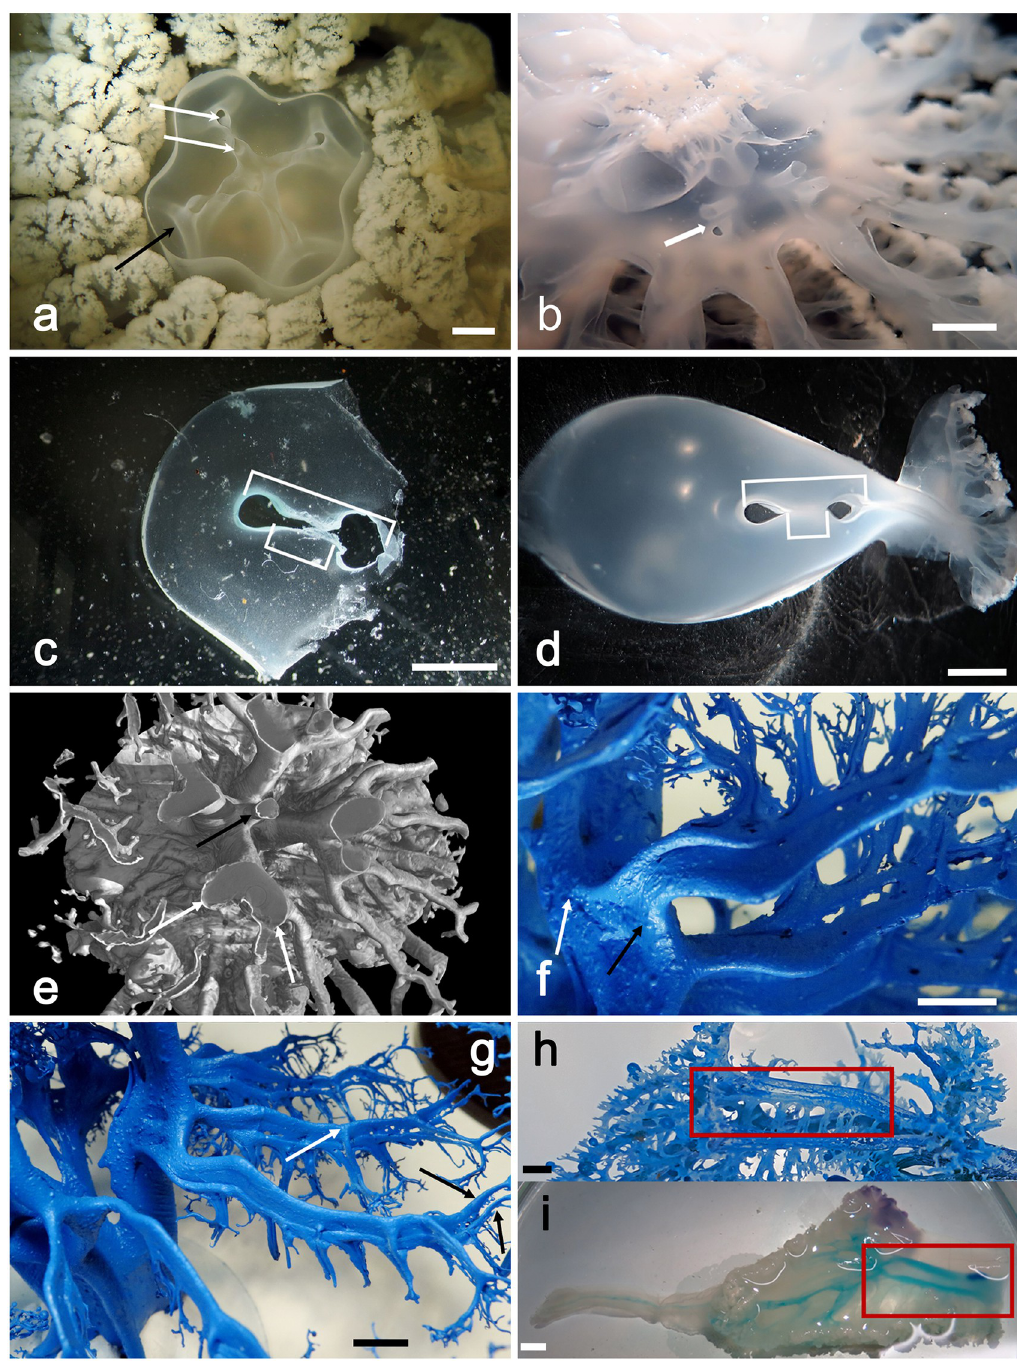
Fig 5. Morphology of the manubrium gastrovascular system. (a) Manubrium section over the emergence of the scapulae, exumbrellar view. Visible the hemi-canals pattern (white arrows) branching from the central cavity, the internal one partially emerging. Black arrow indicates one of the further dichotomic branches of the oral arms duplication (scale bar = 0.5 cm). (b) Section at subscapular level, subumbrellar view (scale bar = 1 cm). Arrow indicates one of the hemi-canal structures. (c) Transverse section of an oral arm at sub scapular level. Larger square bracket indicates the total canal length, smaller one the medial adhering area (scale bar = 0.5 cm). (d) Same as in (c) (scale bar = 0.5 cm). (e) Subumbrellar 3D rendering of a specimen sub-volume obtained by X-ray μ CT; white arrows indicate the dichotomization of two oral arms main canals, black arrow indicates the remnant of the juvenile central mouth opening. CT reconstruction performed with an isotropic voxel size of 62.0 μ m. (f) Endocast of a specimen of 32 cm diam. showing the emergence of the scapular hemi-canal. Arrows indicate